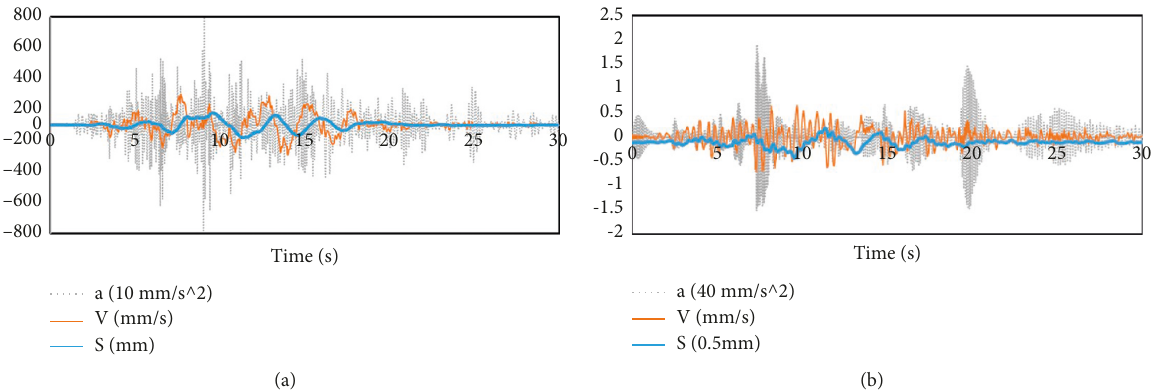
Figure 48: Time course curves of displacement, velocity and acceleration of bearing deformation when REN2 is input from Y direction. (a) Horizontal deformation. (b) Vertical deformation.